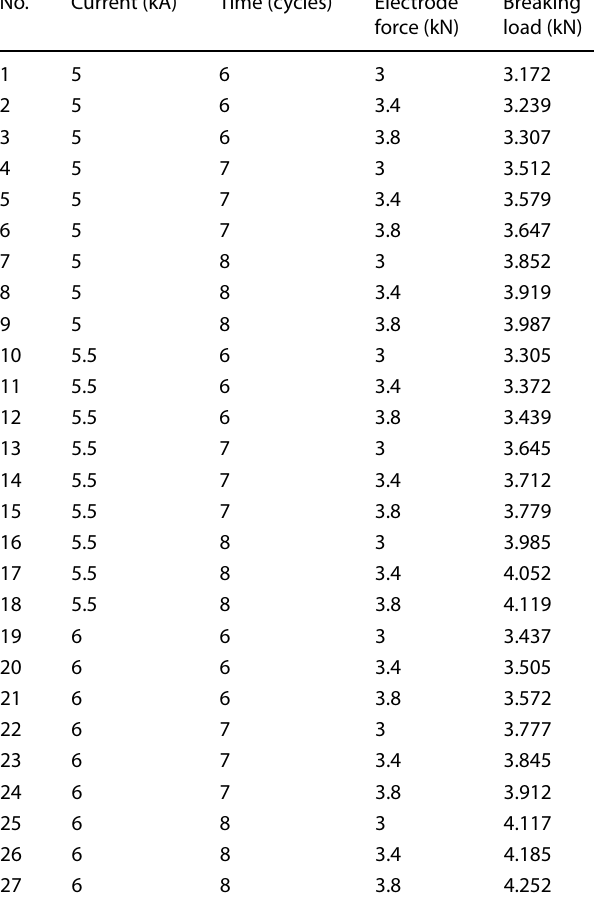
Table 3 Breaking load for welded joints without